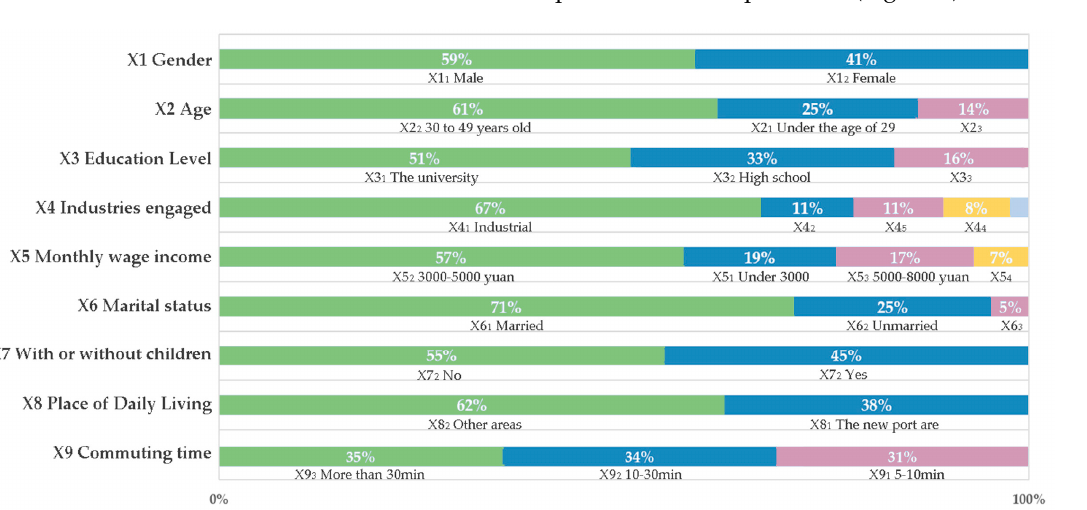
Figure 9. Statistics on the respondents’ basic information in the questionnaire (questions X1–X9).